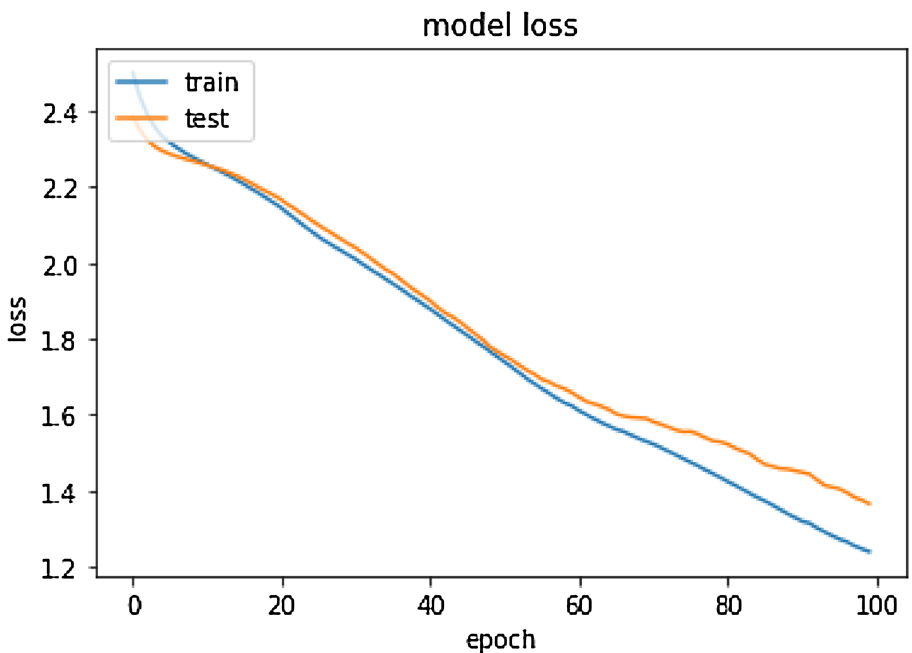
Fig. 3 Validation of model loss